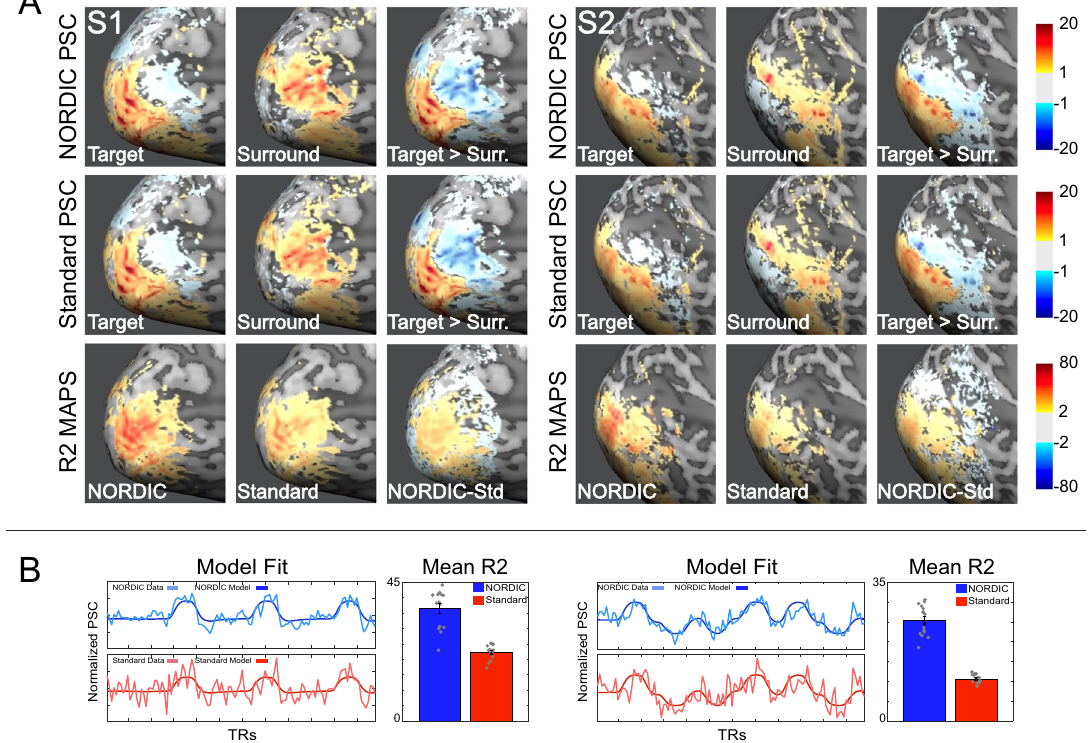
Fig. 4 PSC maps and cross-validated prediction accuracy. Panel A : Average percent signal change (PSC) maps and cross-validated R 2 for both subjects S1 and S2. The top 2 rows in Panel A show the average (across runs) PSC maps elicited by the target (left), surround (middle) and their contrast target > surround (right), for NORDIC and Standard reconstructions, respectively. As evident by these images, PSC amplitude and the extent of stimulus- induced signal change is comparable across reconstructions (see also Supplementary Fig. 5). The 3rd row in panel A shows the average (across folds) cross-validated R 2 maps for NORDIC (left), Standard (middle), and their difference (right). Only in the relevant portion of the cortex for the stimulus used (i.e. areas where stimulus-induced BOLD activity is expected, as indicated by the PSC maps) do the R 2 maps show higher precision of PSC estimates for NORDIC images. Panel B : For each subject, the left column shows a single run of NORDIC and Standard BOLD time-courses for a target-selective voxel (lighter lines) and its prediction estimated on a separate run (darker lines). These plots highlight a closer correspondence between model prediction and empirical time-courses for NORDIC data, as summarized by the signi fi cantly larger (2-sided paired sample t -test; S1: t (14) = 12.8, ci(11.83;16.6), Cohen ’ s d : 3.31 p < 0.01 Bonferroni corrected; S2: t (14) = 20.1, ci(13.33;16.25), Cohen ’ s d : 5.41 p < .01 Bonferroni corrected) target ROI average cross-validated R 2 (bar plots represent the mean and error bars indicate standard errors of the mean across 15 cross-validation folds shown as gray dots). Source data are provided as source Data fi